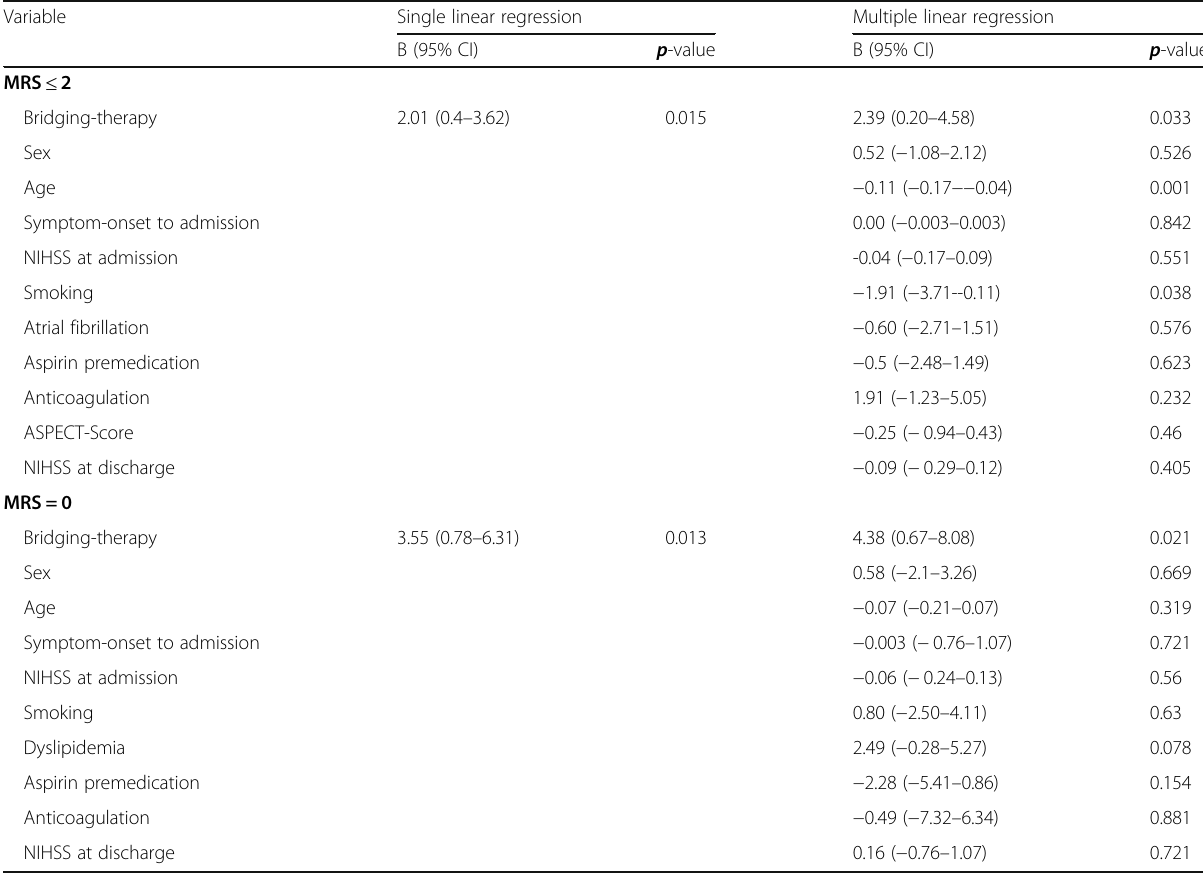
Table 2 Influence of variables on the 90d MoCA value Variable Single linear